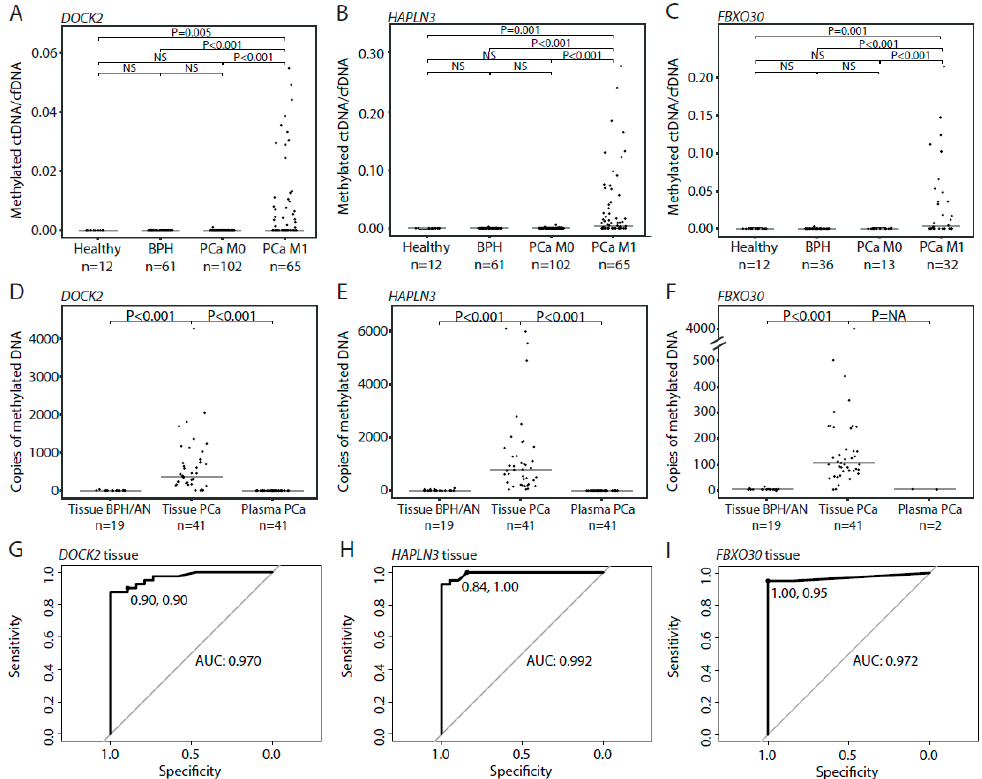
Figure 3. Circulating tumor DNA (ctDNA) detection in plasma and matched PCa tissue samples using MS-ddPCR. ( A – C ) Ratio between methylated ctDNA and cfDNA copies for DOCK2 ( A ), HALPN3 ( B ), and FBXO30 ( C ) in plasma samples from healthy controls, BPH, localized PCa (PCa M0), and metastatic PCa patients (PCa M1). Each dot represents one analyzed sample. ( D – F ) Total number of copies of DOCK2 ( D ), HALPN3 ( E ), and FBXO30 ( F ) in BPH / AN tissue samples, and in matched PCa tissue samples and plasma samples from patients with localized PCa. Each dot represents one analyzed sample. ( G – I ) ROC curves comparing 19 BPH / AN and 41 PCa tissue samples for DOCK2 ( G ), HALPN3 ( H ), and FBXO30 methylation ( I ). p -values were calculated using Mann–Whitney tests. Horizontal bars indicate median values in each group. Healthy, healthy controls. BPH, benign prostatic hyperplasia. PCa, prostate cancer. M0, non-metastatic disease. M1, metastatic disease. ROC, receiver operating curve. AUC, area under the